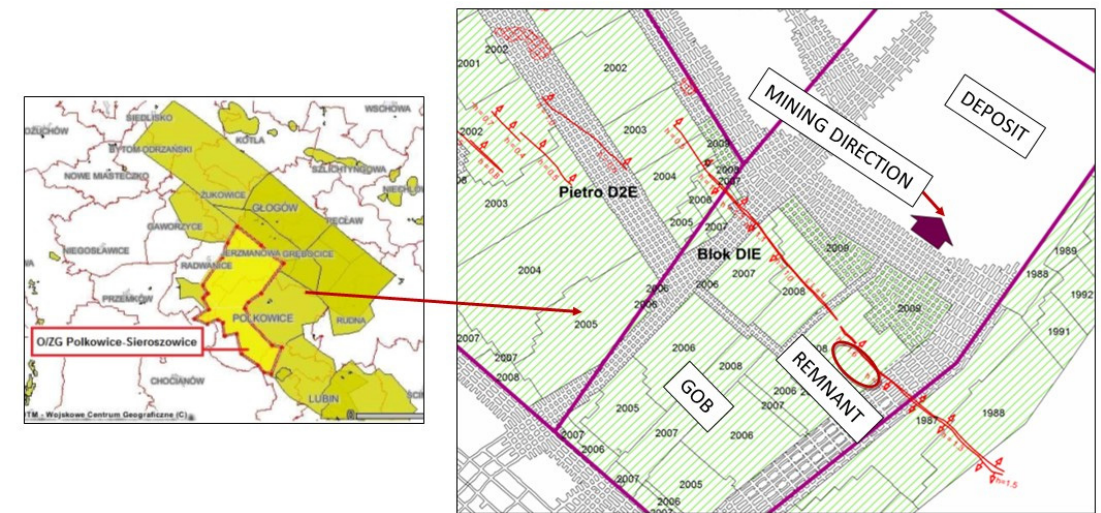
Figure 2. Mining field in the Polkowice-Sieroszowice mine where remnant has been left. In the D-IE mining field, the deposit balance occurs in the lower part of a carbonate series of Permian limestones and the roof part of new red sandstone; it is comprised of grey quartz, fine-grained sandstone, loamy copper-bearing shale, and dolomite loamy shale, as well as streaked, dark grey, crypto-crystalline dolomite. The roof is made of rock layers, being part of a Permian limestone carbonate series, namely of calcareous dolomites with clear divisibility of bed (occurring in intervals of 0–2 m above the excavation roof), of concise calcareous dolomites with quite clear divisibility (occurring in intervals of 2–5 m above the excavation roof), and calcareous dolomites and dolomitic limestones with a bed structure (that occur in intervals of more than 5 m above the excavation roof). The